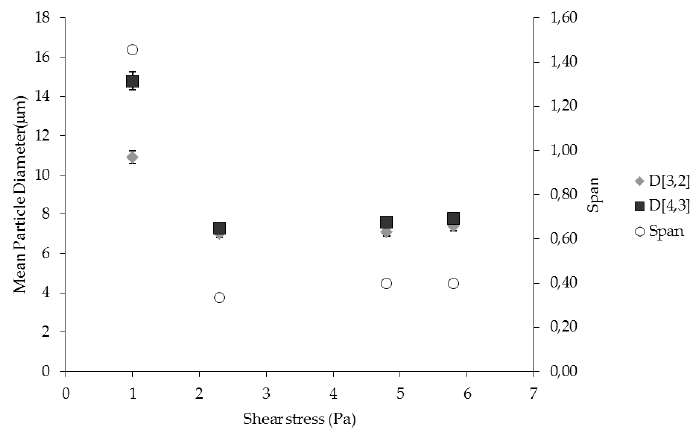
Figure 2. The effect of shear stress on particle size and particle size distribution of W/O emulsion prepared by using pulsed back-and-forward membrane emulsification (dispersed phase flux: 7.2 L h −1 m −2 ; membrane pore size: 3.1